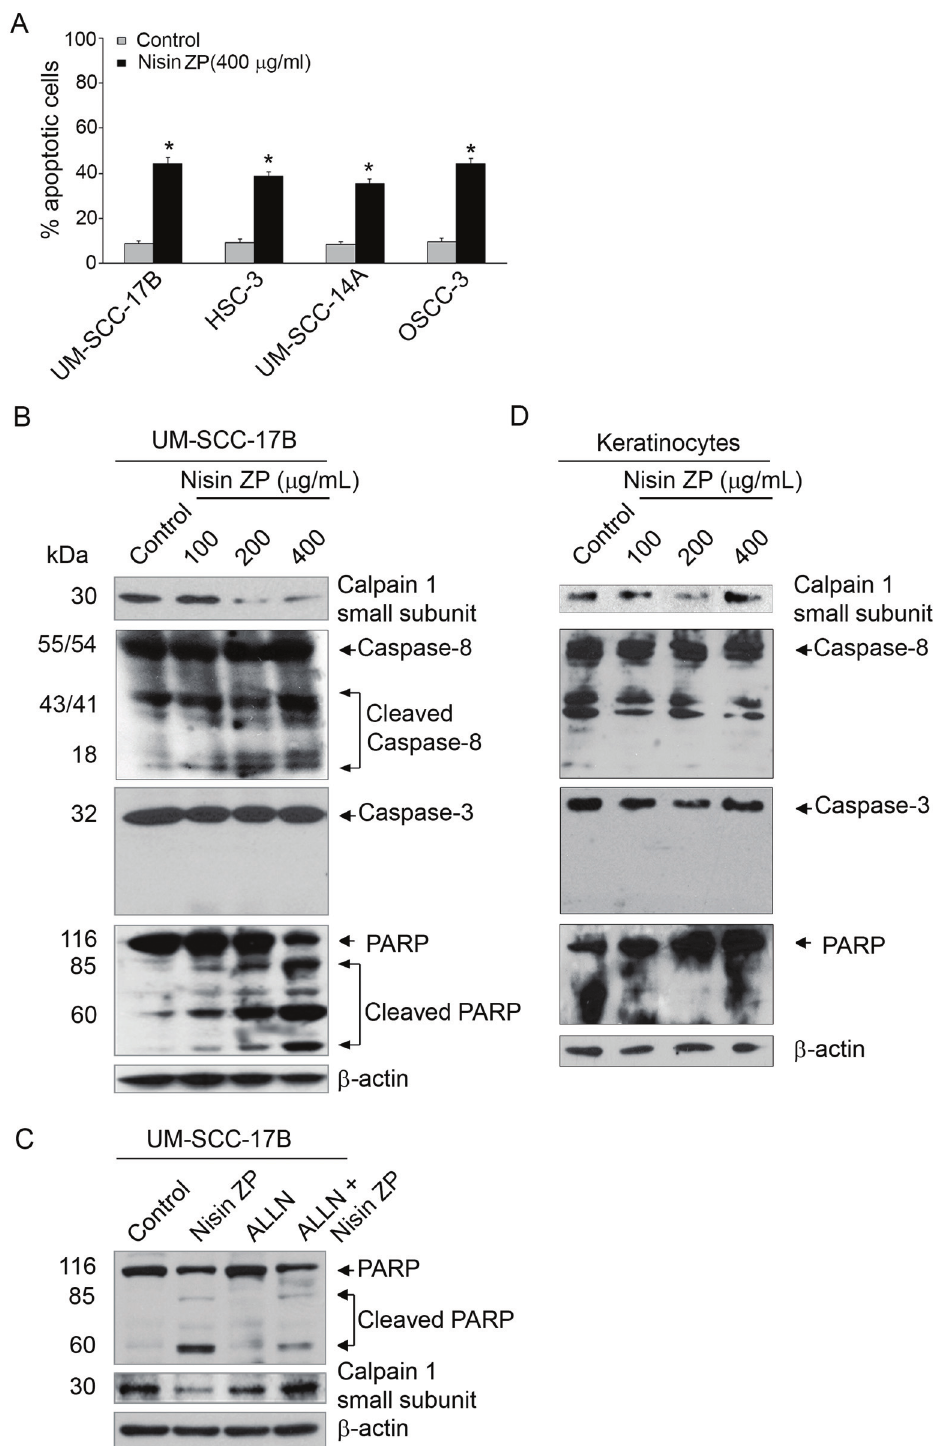
Fig 2. Nisin ZP induces calpain, caspase-8 and PARP activation in HNSCC cells dose-dependently. A , Graphs showing changes in percentage of apoptotic cells (UM-SCC-17B, HSC-3, UM-SCC-14A and OSCC- 3) treated with control media or media containing nisin ZP (400 μ g/mL) for 24 h. Cells were then stained with Annexin V and apoptosis was assessed by flow cytometry. Comparisons between groups relative to controls were analyzed by ANOVA with the level of significance set at * p < 0.05. B , Immunoblots showing calpain